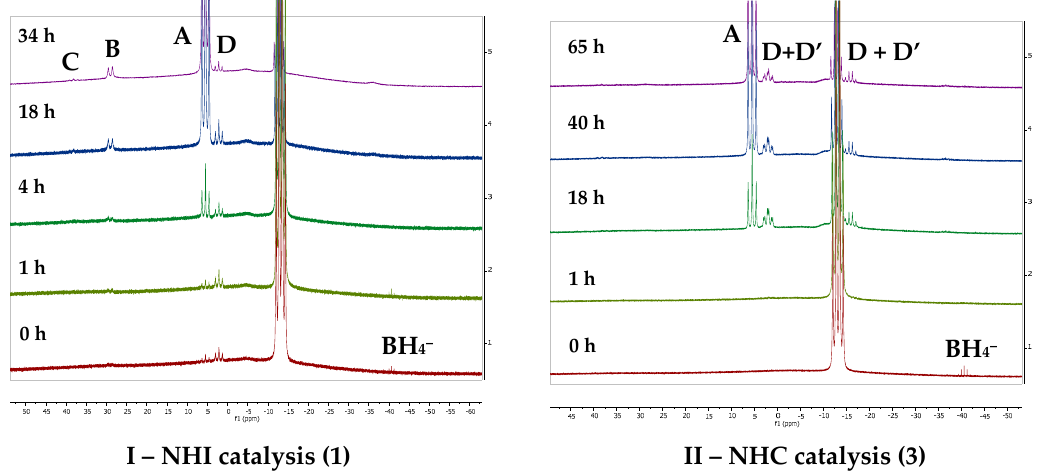
Figure 3. In situ reaction monitoring by 11 B NMR spectroscopy for the catalytic dehydrocoupling of Me 2 NHBH 3 with 1 ( I , left) and 3 ( II , right). A : [Me 2 NBH 2 ] 2 ; B : HB(NMe 2 ) 2 ; C : Me 2 N=BH 2 ; D : [Me 2 NBH 2 N(Me) 2 BH 3 ] − ; D’ : Al bound [Me 2 NBH 2 N(Me) 2 BH 3 ] − .